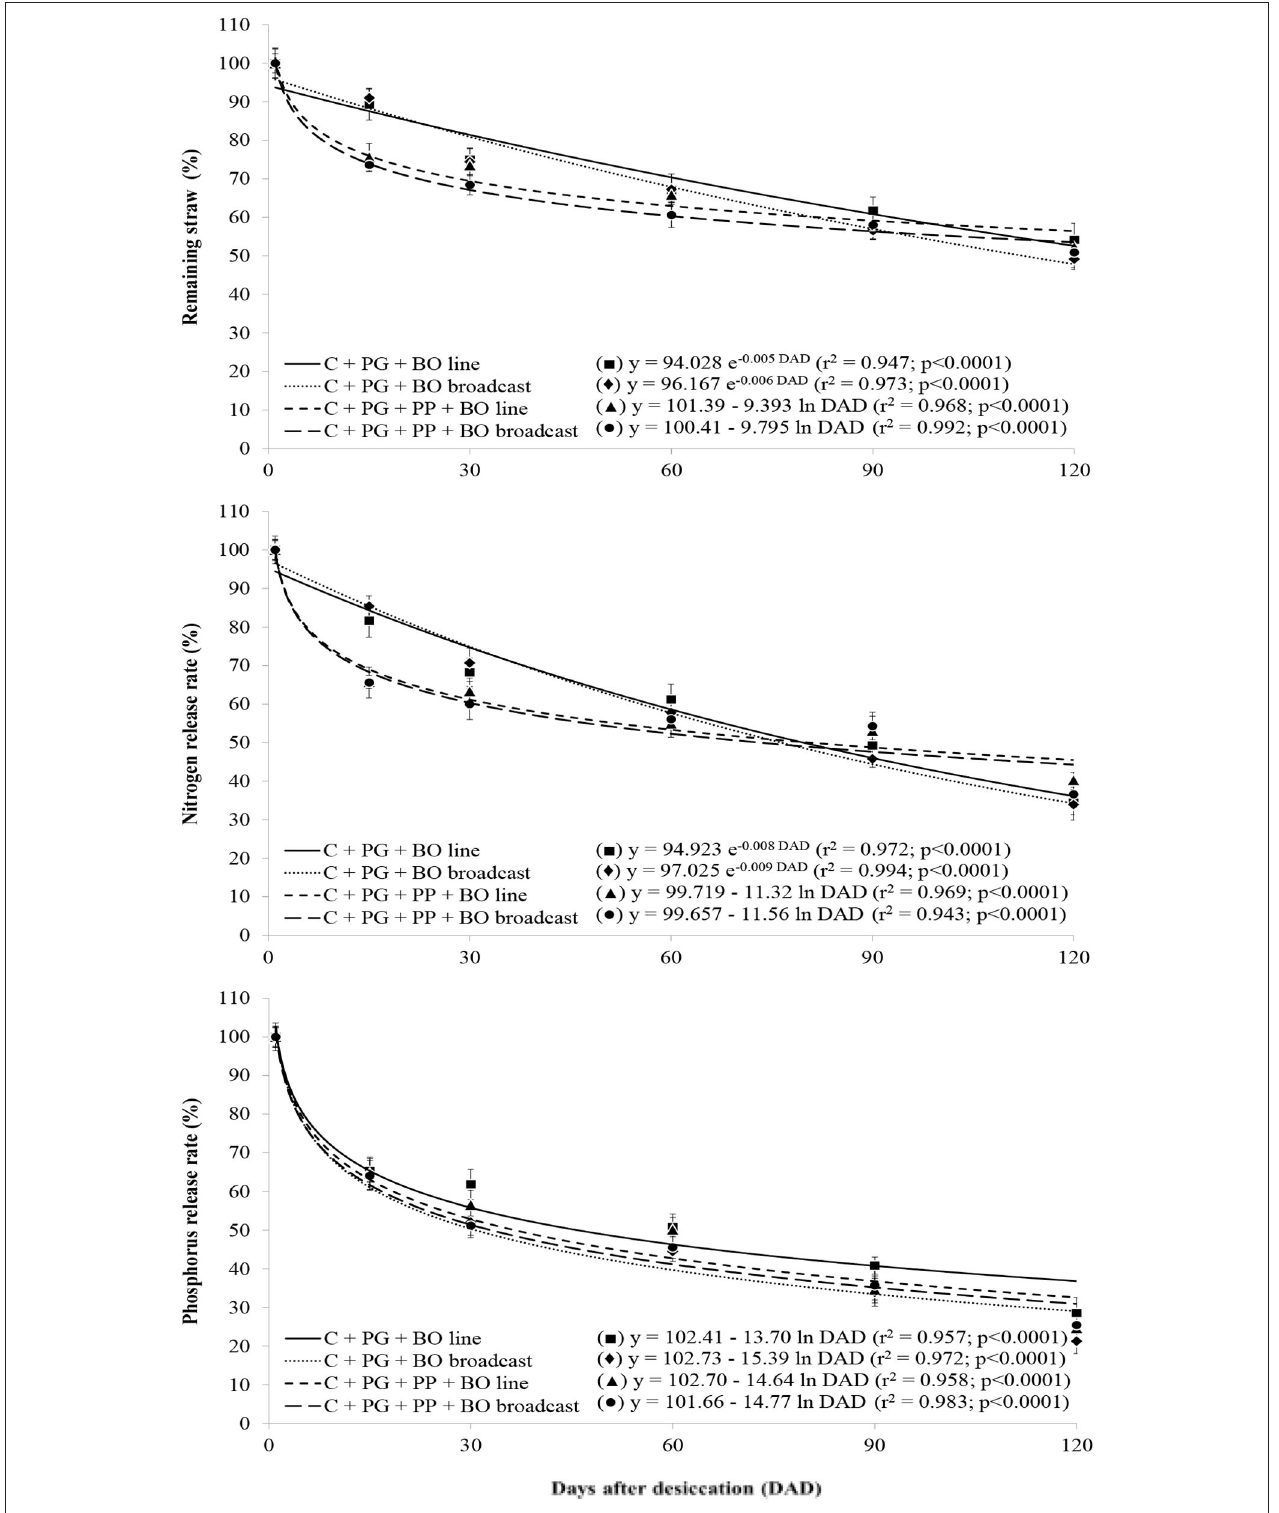
FIGURE 1 | Release rate of remaining straw, nitrogen, and phosphorus in palisade grass (PG) intercropped with corn (C) and with corn and pigeon pea (PP) to silage with black oat (BO) oversown in lines and broadcast after grazing by lambs as a function of days after desiccation (mean of three growing seasons). Values are the mean of 12 replicates, and the associated error bar is ± 1 SE. Days after desiccation (DAD): days after pasture and weed desiccation with glyphosate herbicide, after grazing by lambs.